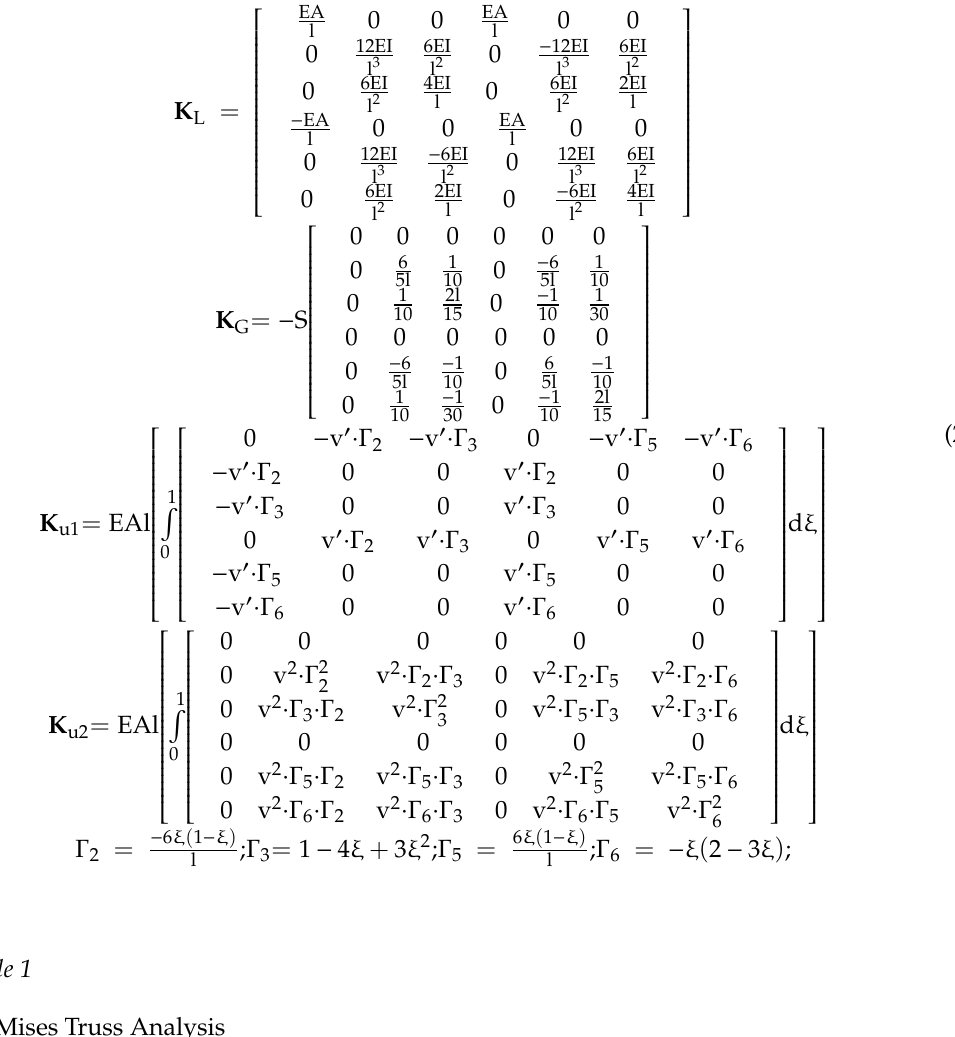
Table 1. Values of axial force and nodal displacement. Force/Displacement/Analysis